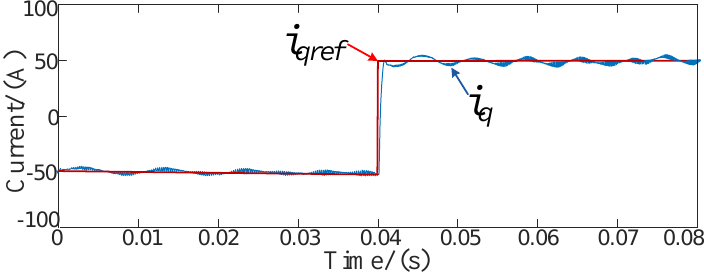
Figure 17. Simulation results of the difference between the reference current and actual values.